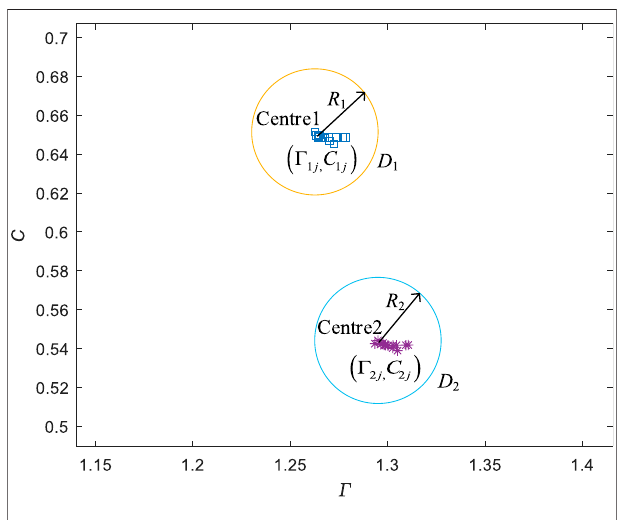
FIGURE 4 | Schematic diagram of the cluster and feature-hood.